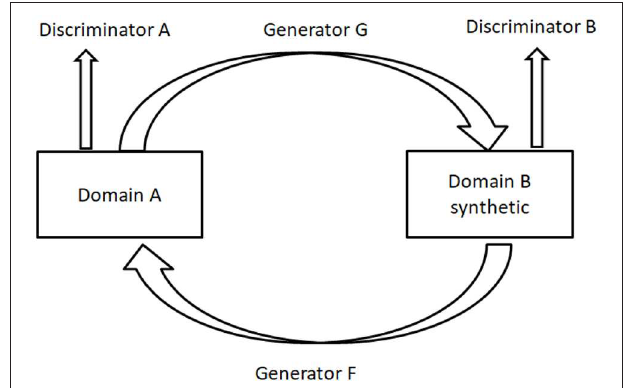
FIGURE 2 | The architecture of